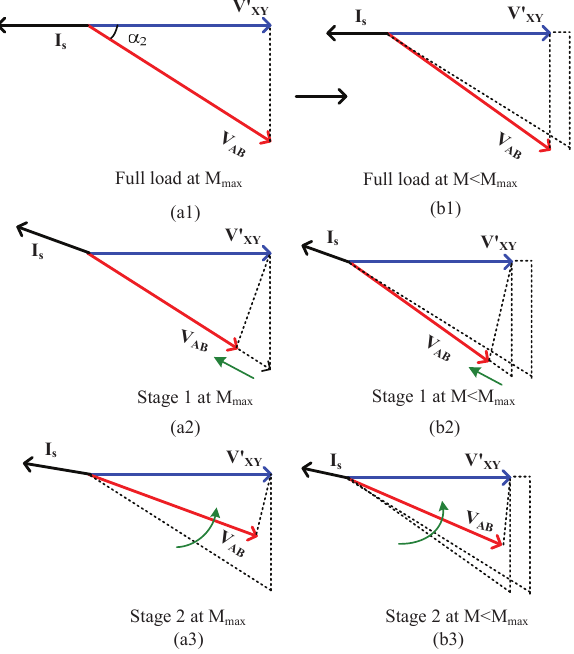
Figure 7. Phasor diagram of the DBSRC with the PW-DPS control strategy for negative power